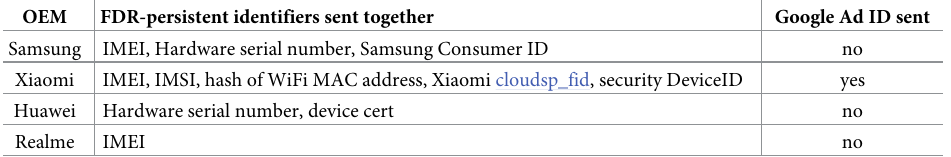
Table 3. FDR-persistent identifiers sent together in same network connection (and so trivially linkable), plus whether Google Ad ID is sent in the same connection (so making it trivially linkable to the FDR-persistent